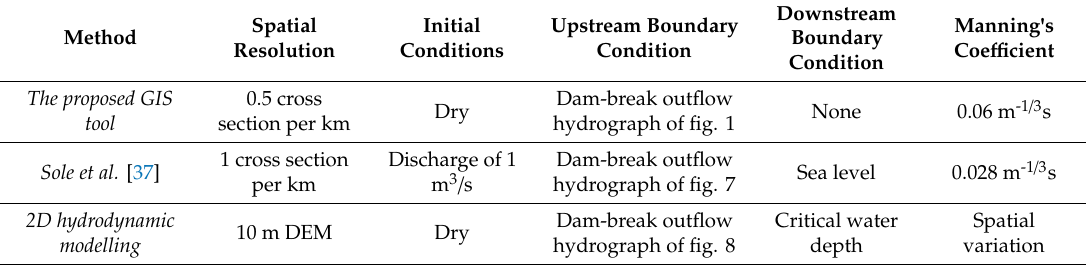
Table 1. Summary of the numerical modelling setup for the San Giuliano case study by Sole et al. [37], by the two-dimensional (2D) numerical model of Cantisani et al. [40] and by the proposed GIS tool.